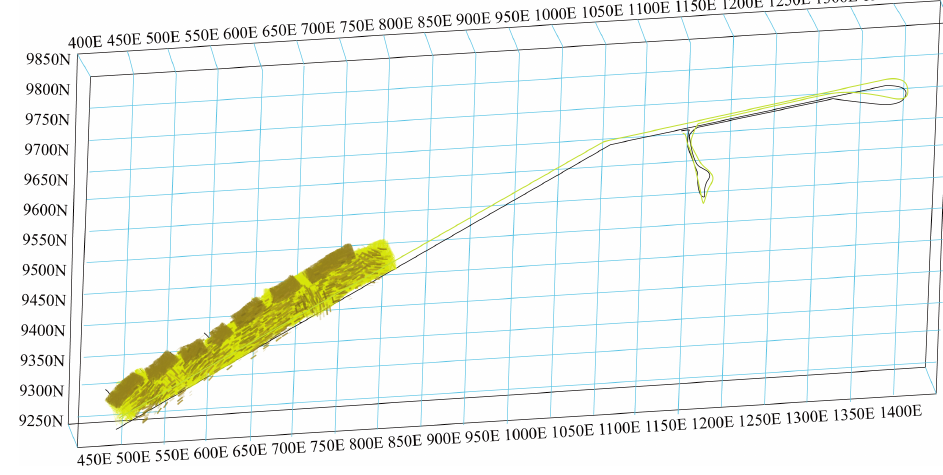
Figure 4: Solid model of stope and roadway in the middle section indicating stope −